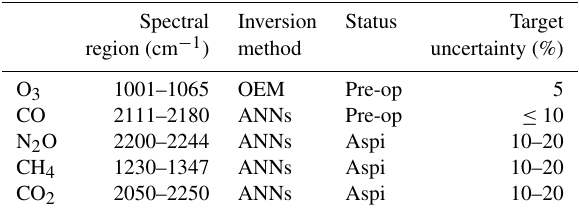
Table 2. Description of the IASI L2 V5 trace gas products: spectral regions used for the retrievals, type of inversion algorithm (ANNs: artificial neural networks; OEM: optimal estimation method), sta- tus of the different products (Pre-Op: pre-operational; Aspi: aspira- tional), and target uncertainty within the IASI